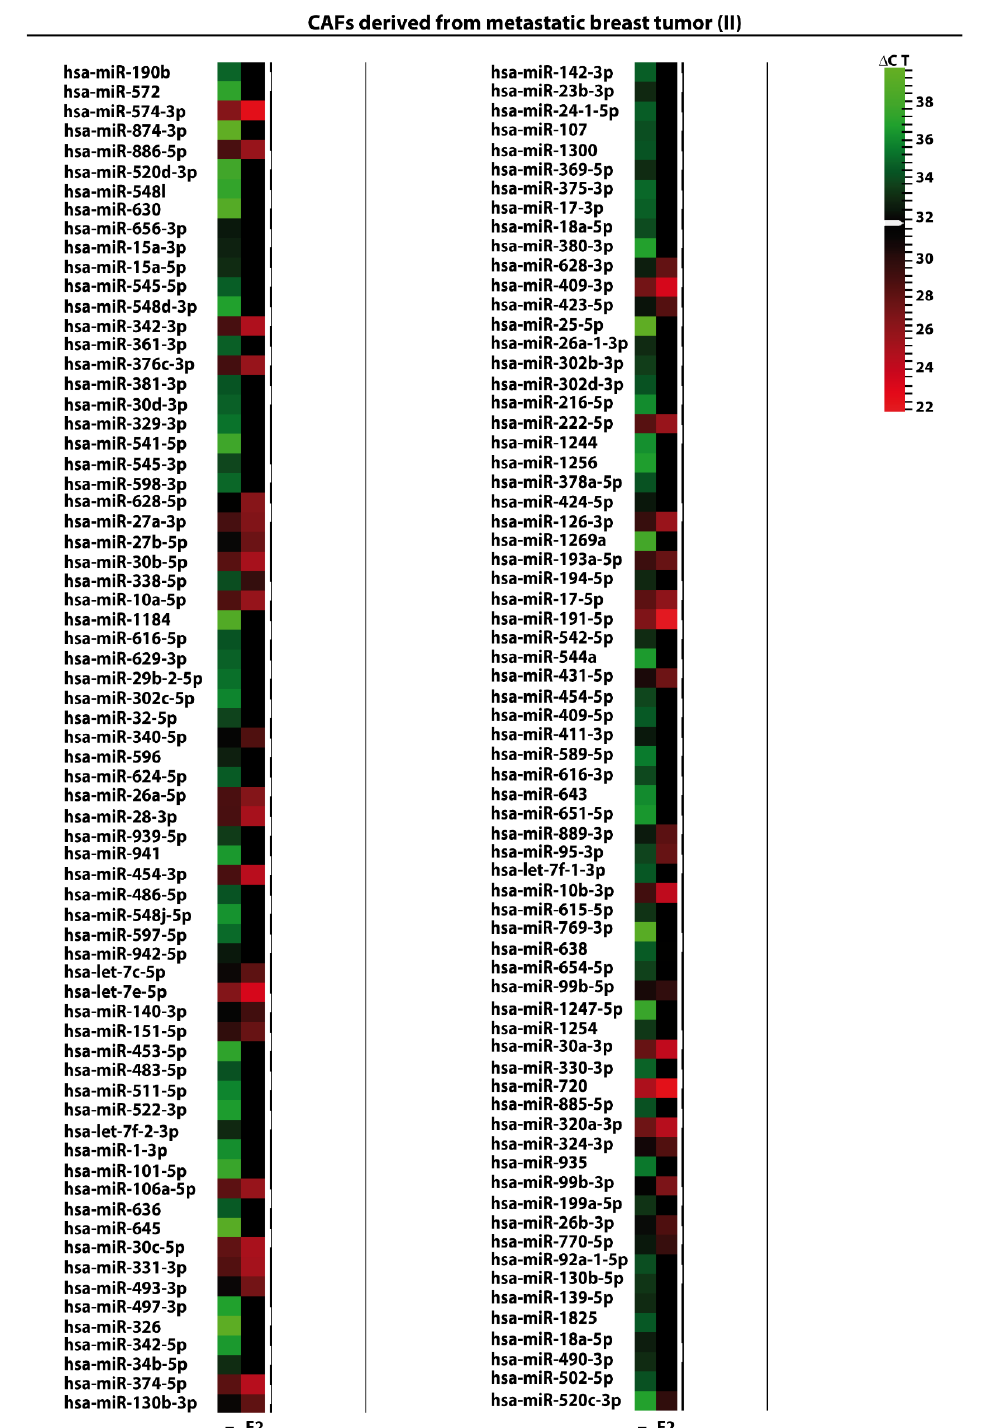
Dendrograms of clustering analysis for miRNAs and samples are displayed on the top and right, respectively.